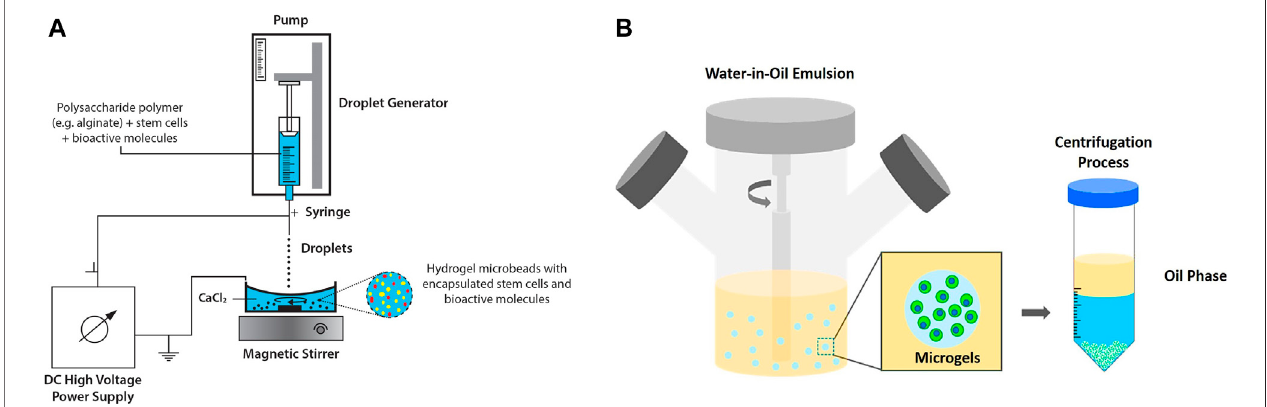
FIGURE 3 | Extrusion and emulsion methods. (A ) Electrostatic/electrospray droplet extrusion technique for microencapsulation of stem cells and bioactive molecules. Figure adapted with permission from Figure 1 of (Verica et al., 2008). (B) Emulsi fi cation technique (water-in-oil emulsion) produces hydrogels for cell encapsulation. Figure adapted with permission from Figure 6 of (Choe et al.,